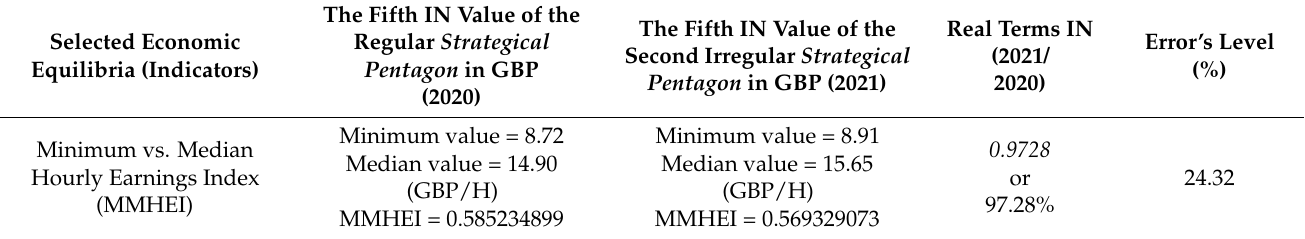
Table 4. The value of the fifth essential MID indicator adequate in a “strategical” and conjunctural pentagon, based on UK data, detailed as IN for “5-gon” GAIN.